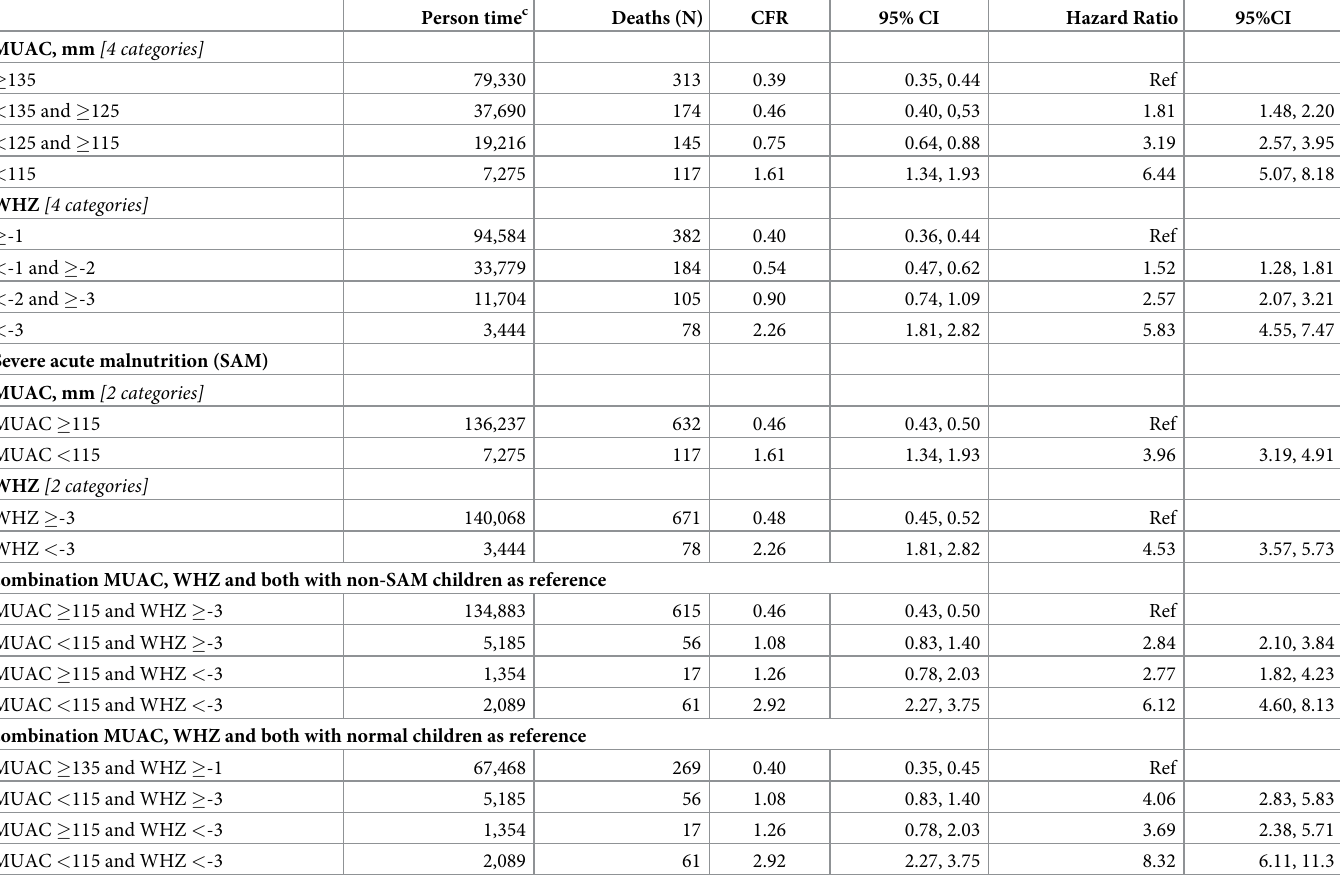
Table 3. Case fatality rate (CFR) a and hazard ratio (HR) resulting from Cox proportional hazard regression models b for all measurements in children aged 6–59 months